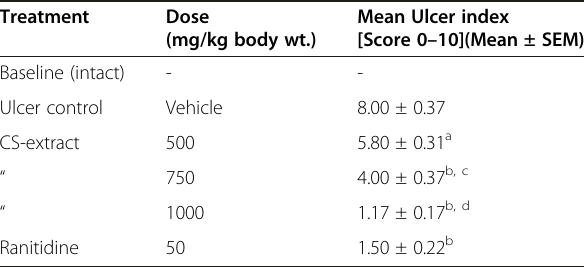
Table 1 Effect of C. sieberiana (CS) root bark extract on ulcer index in ethanol-induced gastric ulcer rats Treatment Dose (mg/kg body wt.)